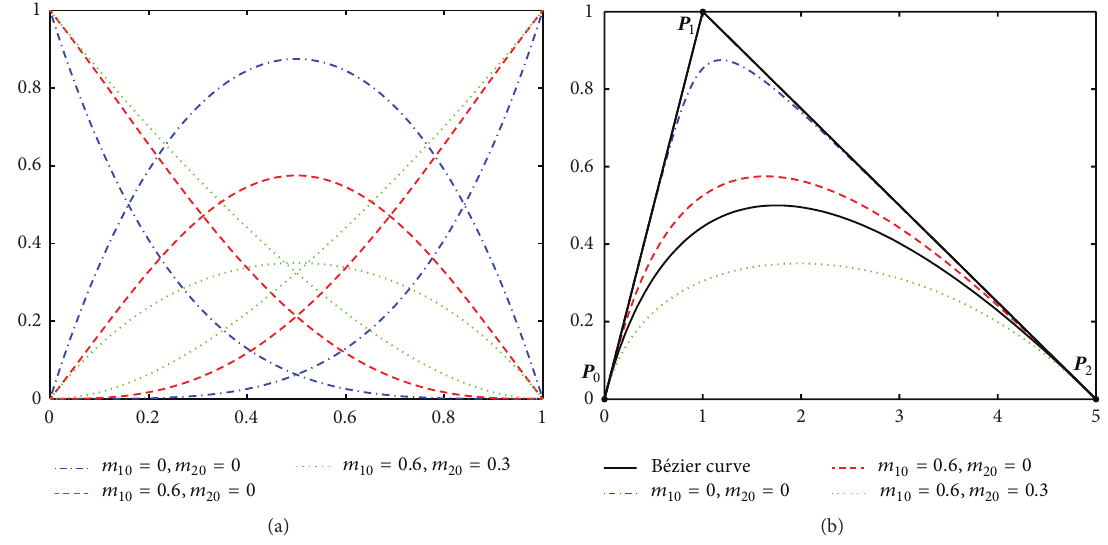
Figure 2: Quasi-Bernstein basis functions and Quasi-B´ezier curves when 𝑛 1 = 2 and 𝑛 2 = 4 .